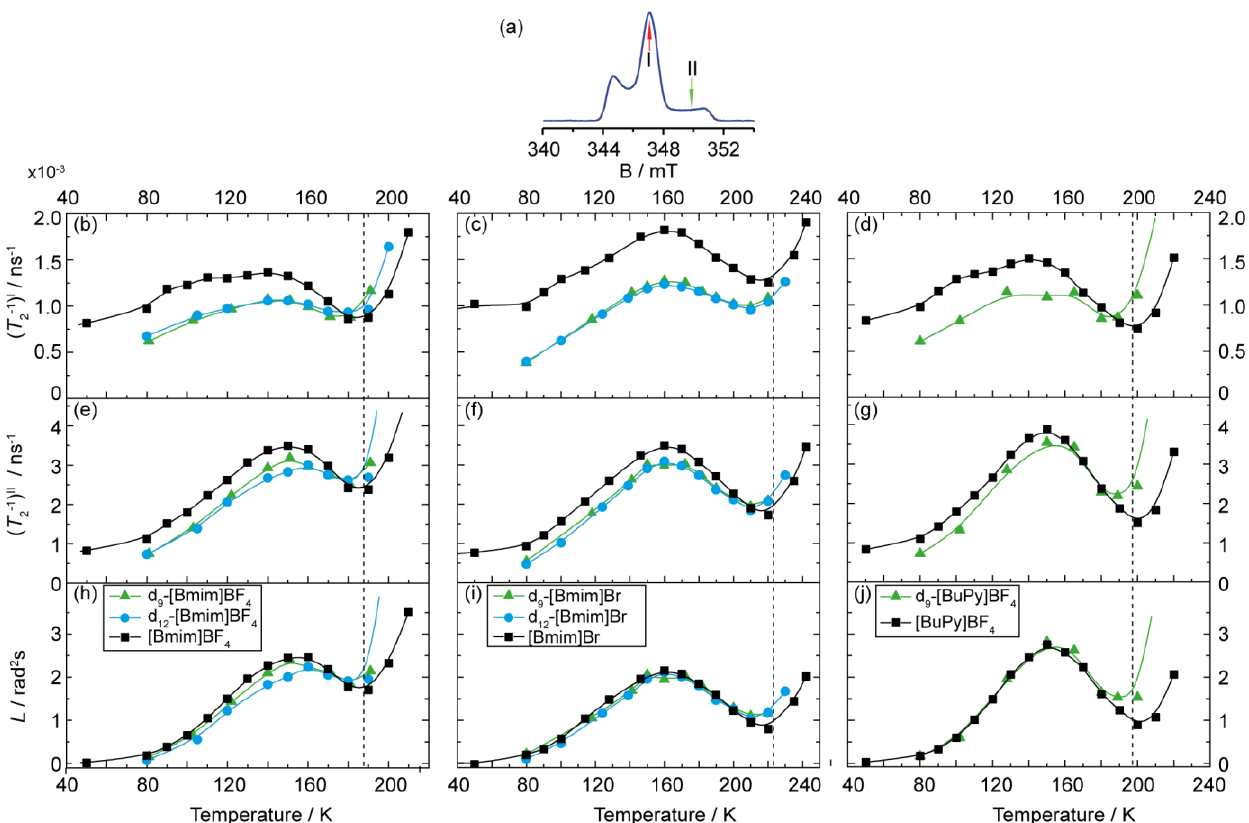
Figure 2. ( a ) Illustrative echo-detected spectrum with indicated field positions I and II where T 2 was measured, B is the magnetic field. ( b – g ) Temperature dependence of T 2 − 1 recorded in corresponding spectrum position for protonated and deutered ILs listed in Scheme 1. ( h – j ) Temperature dependence of the motional parameter L for nitroxide radical N1 in ILs, see text for details. Vertical dashed lines show the corresponding T g values for each IL: T g = 188 K for [Bmim]BF 4 [56], T g = 223 K for [Bmim]Br[77] and T g = 197 K for [BuPy]BF 4 [56].